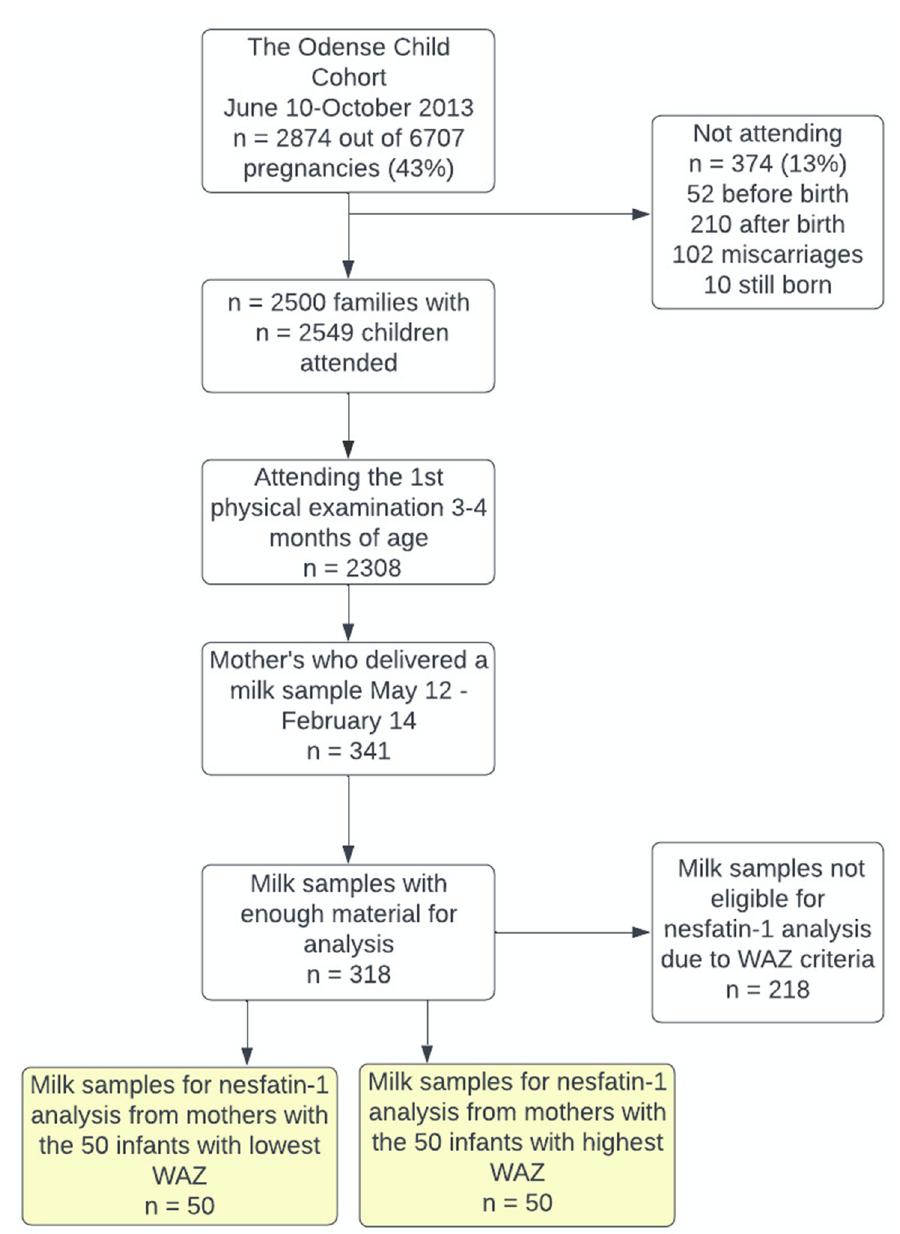
Figure 1. Flowchart of inclusion. (WAZ) Weight-for-age-z-score.